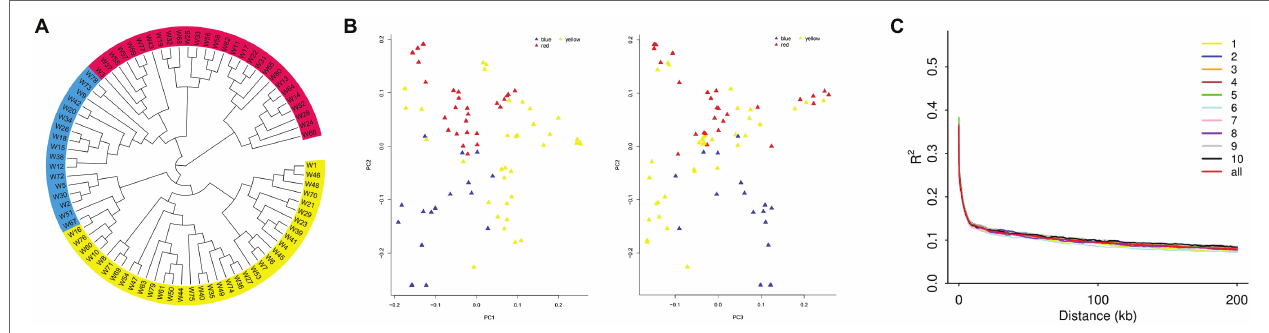
FIGURE 3 | (A) The population structure, (B) Principal Component Analysis (PCA), and (C) linkage disequilibrium (LD) diagram for population